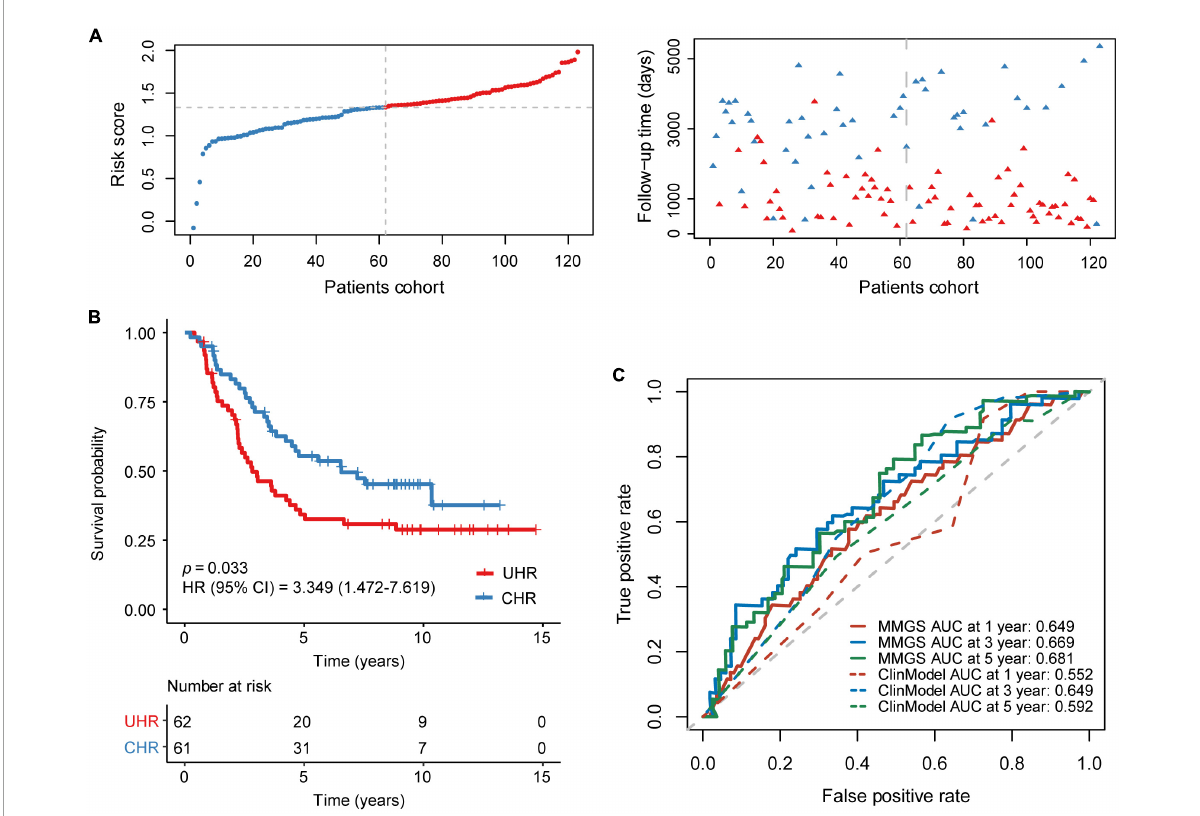
FIGURE3 Validation of MMGS in the TARGET HRNB cohort. (A) The distribution of risk score and survival status. (B) KM curves of OS between the UHR and CHR groups. (C) ROC curves of MMGS model (solid lines) and clinical model (dot lines) to predict the 1-, 3-, and 5-year OS. ClinModel, clinical model; HR, hazard ratio; CI, confidence